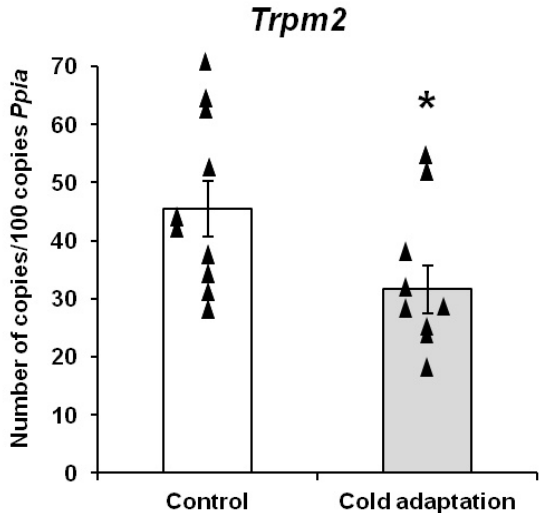
Figure 1. Effect of long-term adaptation to cold on expression of the Trpm2 gene in the hypothalamus of rats. Significant differences between the control and cold-adapted rats: * p < 0.05 ( p = 0.044, t = 2.17). Triangles represent the individual values.